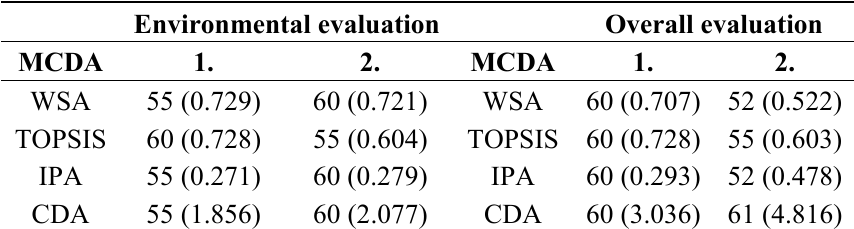
Table 10. Final MCDA scores for on-the-ground floors.